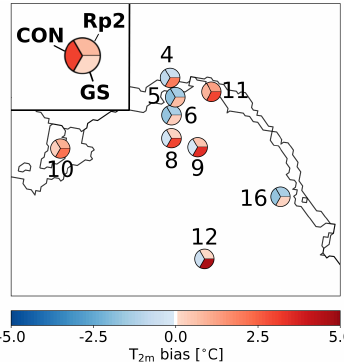
Figure A2. Bias of monthly-averaged 2m temperature ( T 2m ) using AWS data of DML between 1997 and 2012. Each numbered circle chart represents an AWS station (locations shown in Fig. 2b) and is split into three parts: the upper right shows the bias of Rp2 with observations, the lower right GS and the left CON.